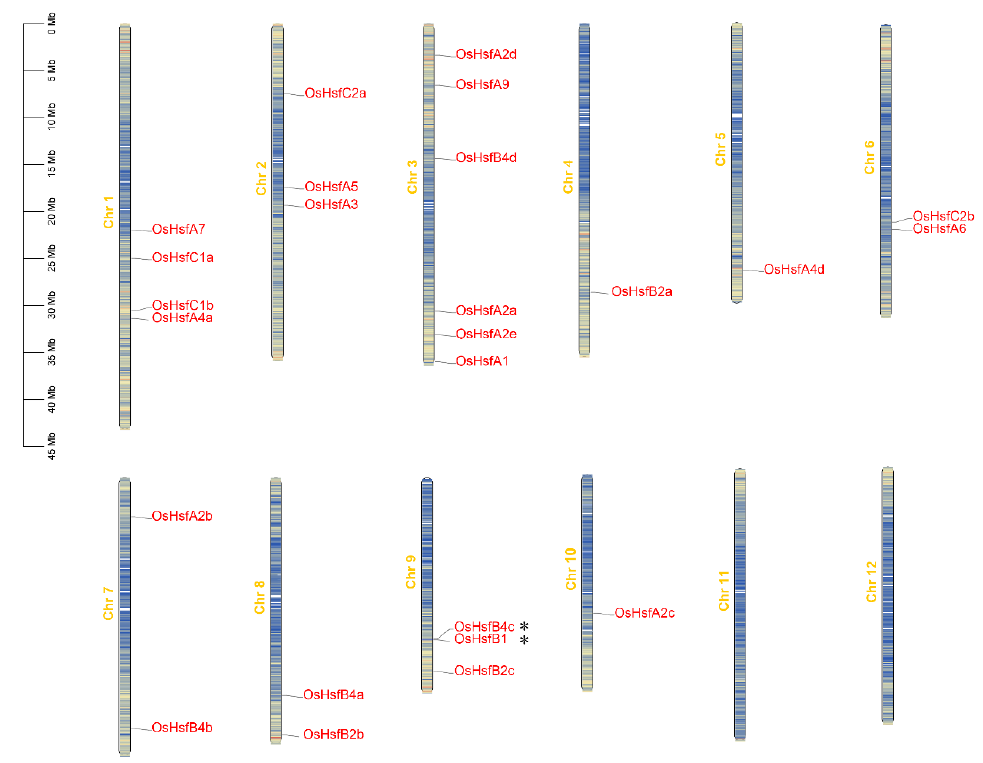
Figure 2. Schematic representations for chromosomal localization and gene duplication events of OsHsf genes. Twenty-five OsHsf genes were unevenly mapped on the 10 chromosomes. The lines represent the gene density in each chromosome. * indicated the tandem duplication events of OsHsfs .